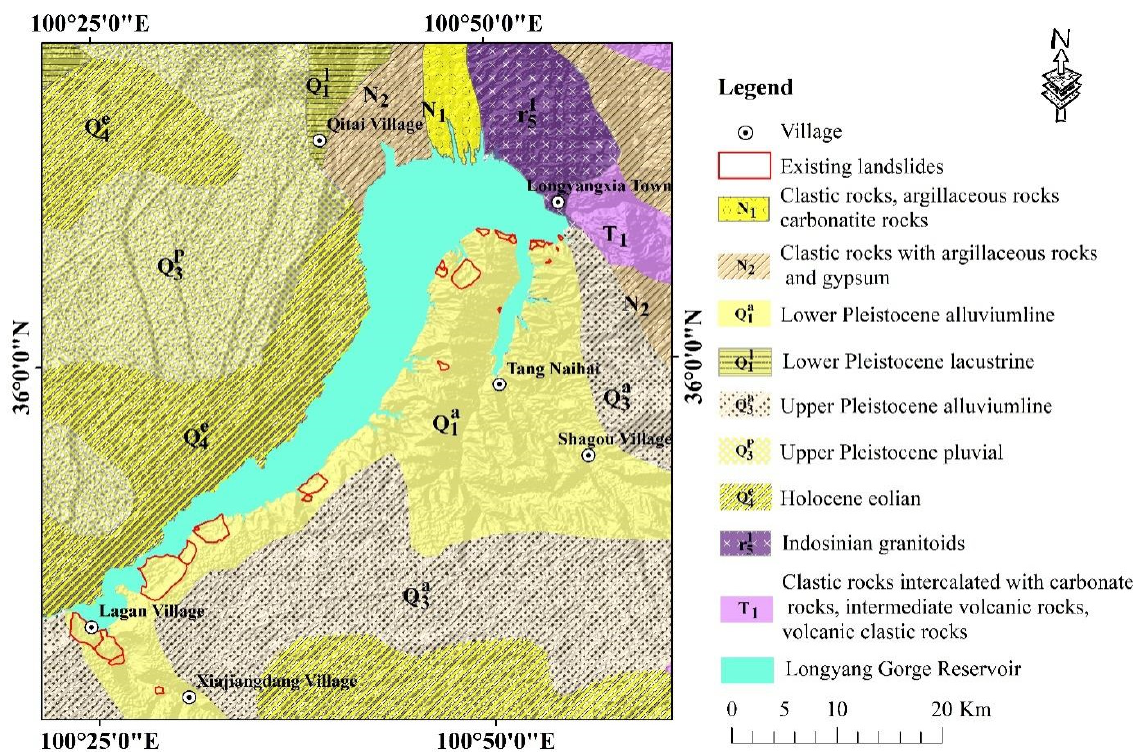
Figure 3. Geological map of the Longyangxia Reservoir area is digitized from reference [3].